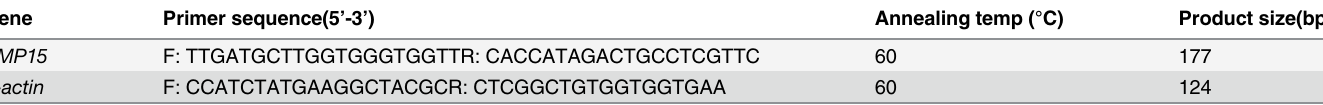
Table 2. Primer parameters for